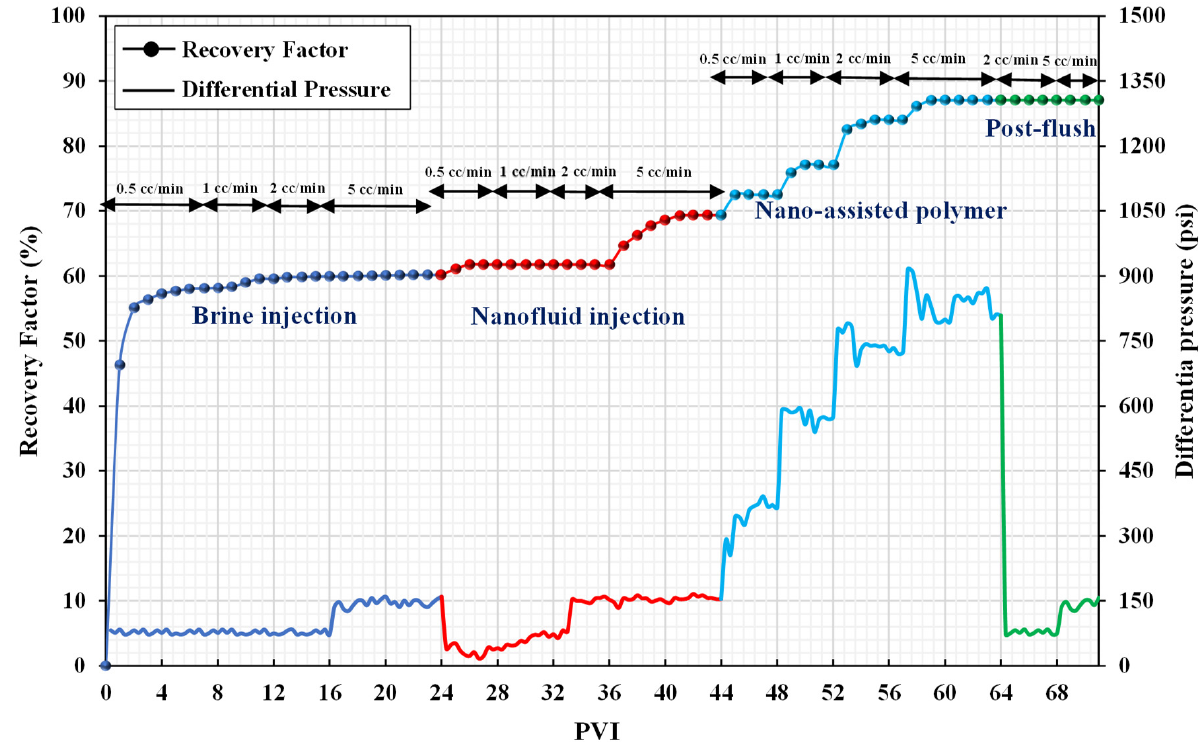
Figure 9. Recovery factors and differential pressure versus PVI (coreflood-3).